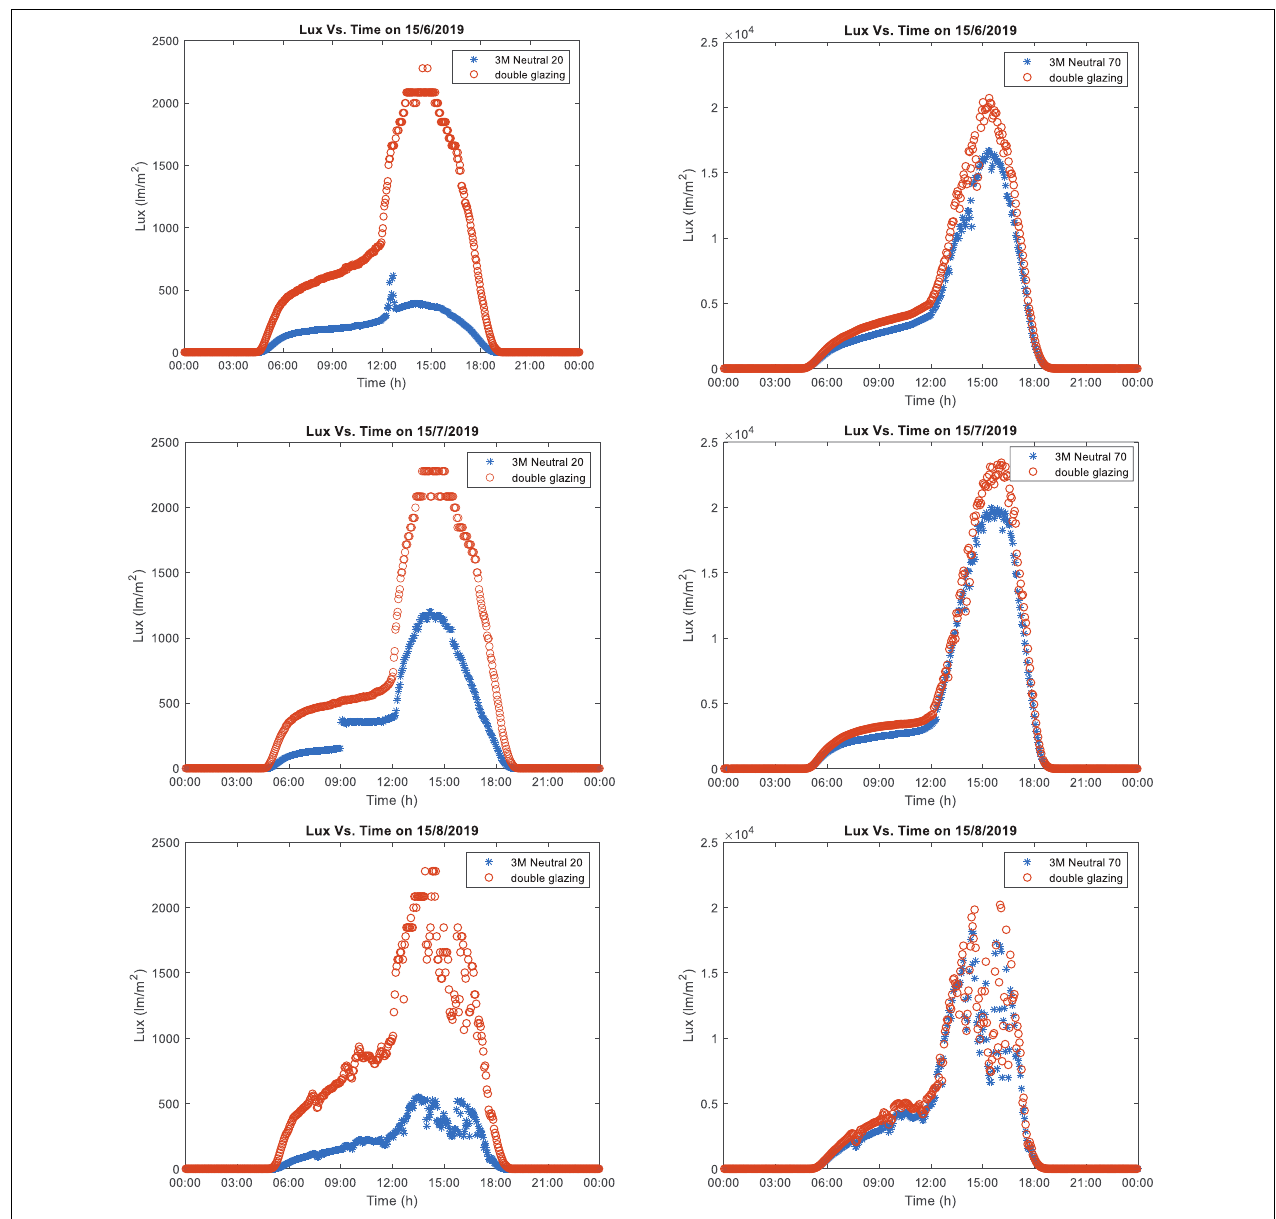
FIGURE 6 | Illuminance of two offices with 3M Neutral 20 and 3M Neutral 70 window films on the 15th day of the months June, July, and August